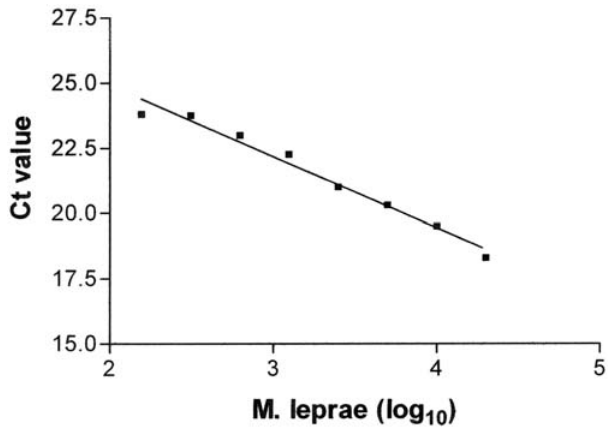
Figure 1. RLEP TaqMan PCR results from titration of nude mouse-derived M.leprae . Serial 2-fold dilutions of M. leprae were made from 2 6 10 6 to 1.56 6 10 4 /ml. Ten microliters of each dilution were tested in triplicate representing 2 6 10 4 to 156 M. leprae in the test sample, respectively. The ordinate is PCR cycle number at threshold and the abscissa is number of M. leprae (log 10 ). Standard deviations did not exceed 0.5% of mean at any dilution.